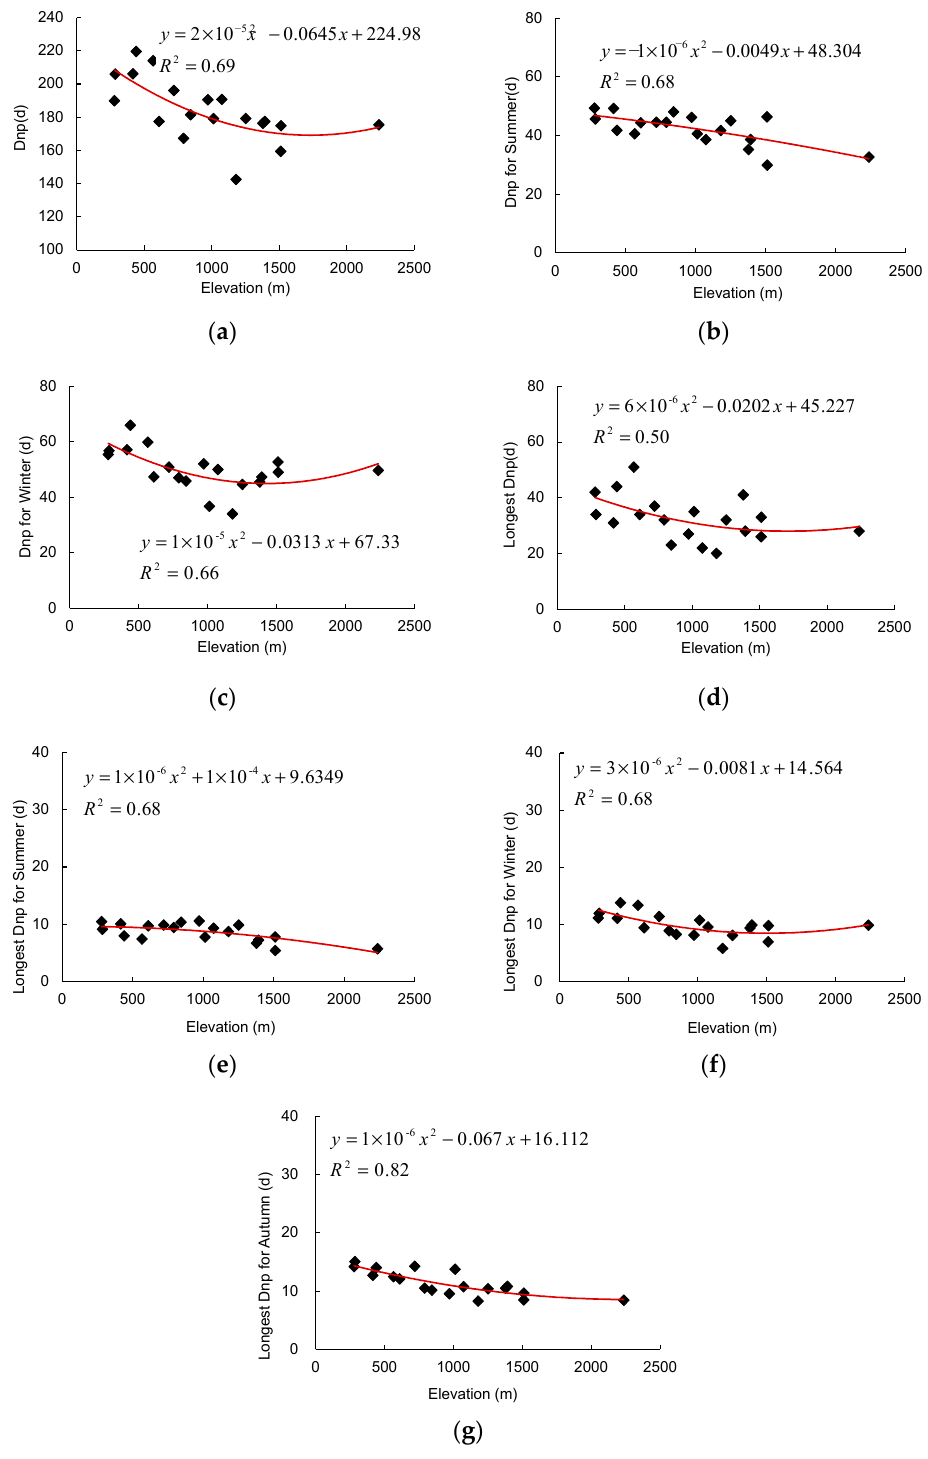
Figure 12. ( a ) Dnp, ( b ) Dnp in summer, ( c ) Dnp in winter, ( d ) longest Dnp, ( e ) longest Dnp in summer, ( f ) longest Dnp in winter, ( g ) longest Dnp in autumn versus elevation.